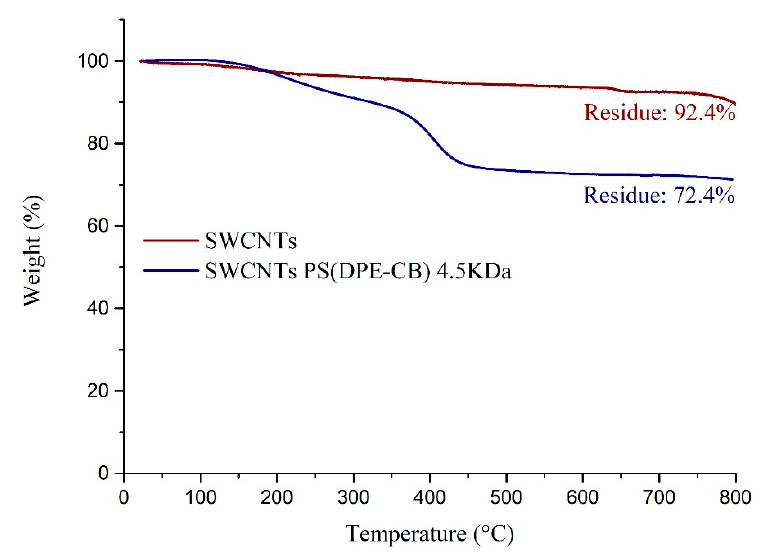
Figure 4. Thermogravimetric analysis under nitrogen atmosphere employing a heating rate of 10 °C/min of pristine SWNTs and SWNTs- g -PS.